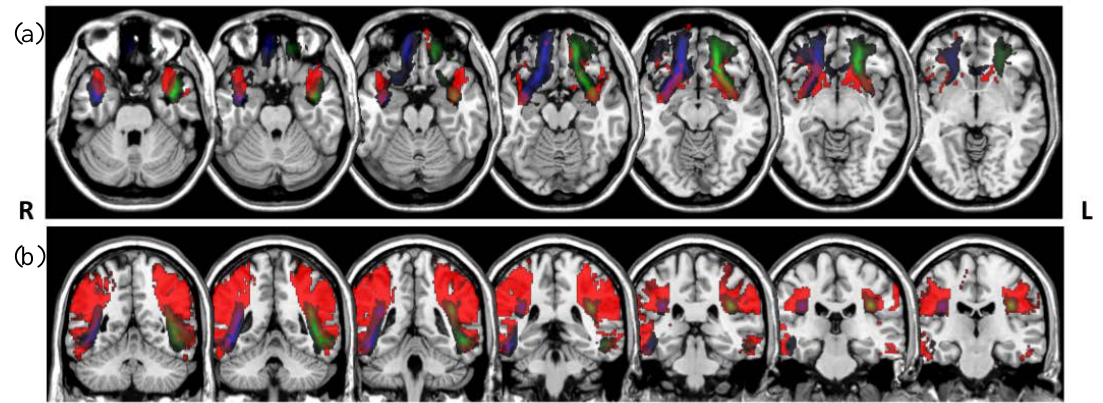
L = left, R = right, Arc = arcuate fasciculus, ATR = anterior thalamic radiation, Cing = cingulum (split into dorsal and ventral segments), ILF = inferior longitudinal fasciculus, CST = corticospinal tract, Unc = uncinate fasciculus.